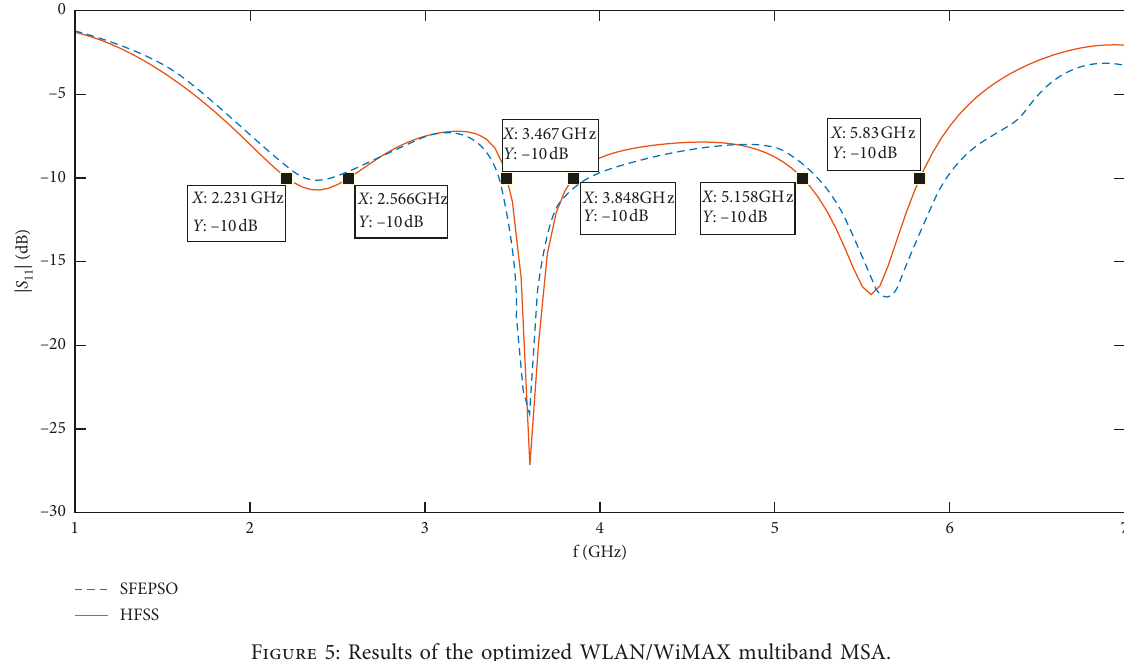
Figure 5: Results of the optimized WLAN/WiMAX multiband MSA.